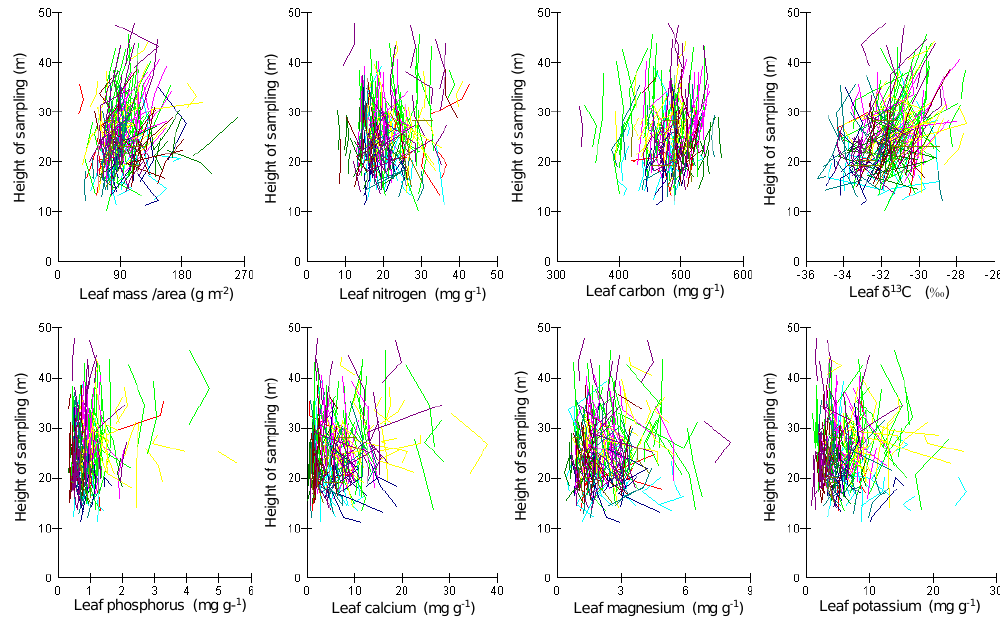
Fig. 6. Vertical gradients in leaf mass per unit area, [N] DW , leaf [C] DW , δ 13 C, [P] DW , [Ca] DW , [Mg] DW and [K] DW for 204 trees sampled across Amazonia. Different colours refer to different regions.